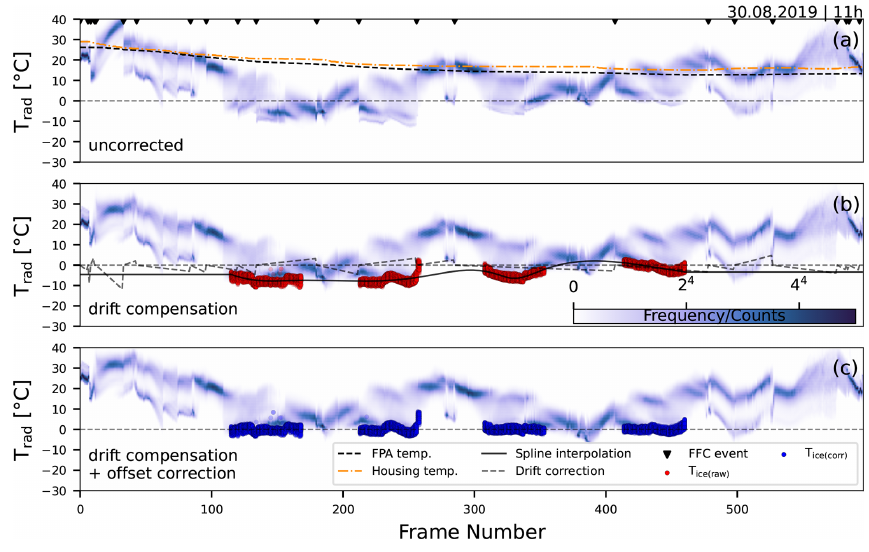
Figure 2. Thermal correction and calibration using bare-ice temperatures at 11:00 (UTC + 1) on 30 August 2019. The histogram time series in the figure displays the frequency of measured temperatures in each thermal infrared image, with each vertical stripe representing one image. (a) Raw at-sensor (brightness) temperature with detected flat field correction events (black triangles). The temperatures of the focal plane array (FPA) and housing case returned by the sensor are shown in orange and a bold, dashed black line. (b) Drift-compensated temperatures with ice surface temperatures (red dots) and thermal drift correction offset (dashed line). The black line shows the spline interpolation of the measured ice surface temperatures with the edges set to a constant value. (c) Offset-corrected temperatures, each frame based on the spline interpolation that the ice surface temperatures are at 0 ◦